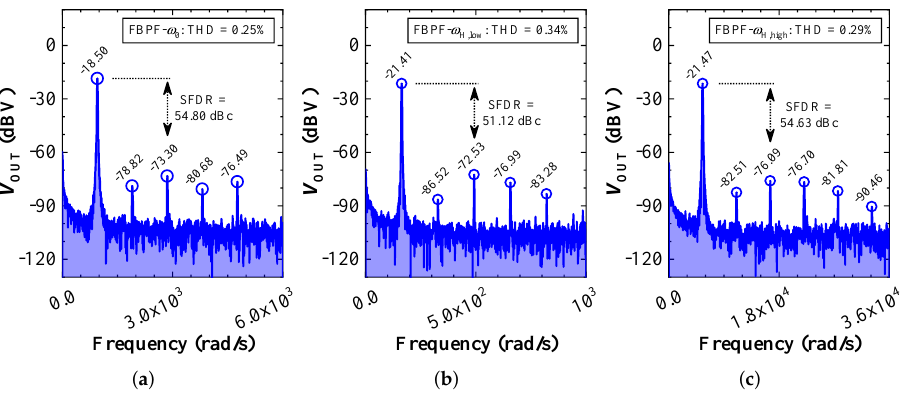
Figure 17. Experimentally obtained Fourier spectrums of the proposed FBPF at frequency of ( a ) ω 0 = 952.53 rad/s, ( b ) ω H,low = 164.18 rad/s, and ( c ) ω H,high = 5.52 krad/s.